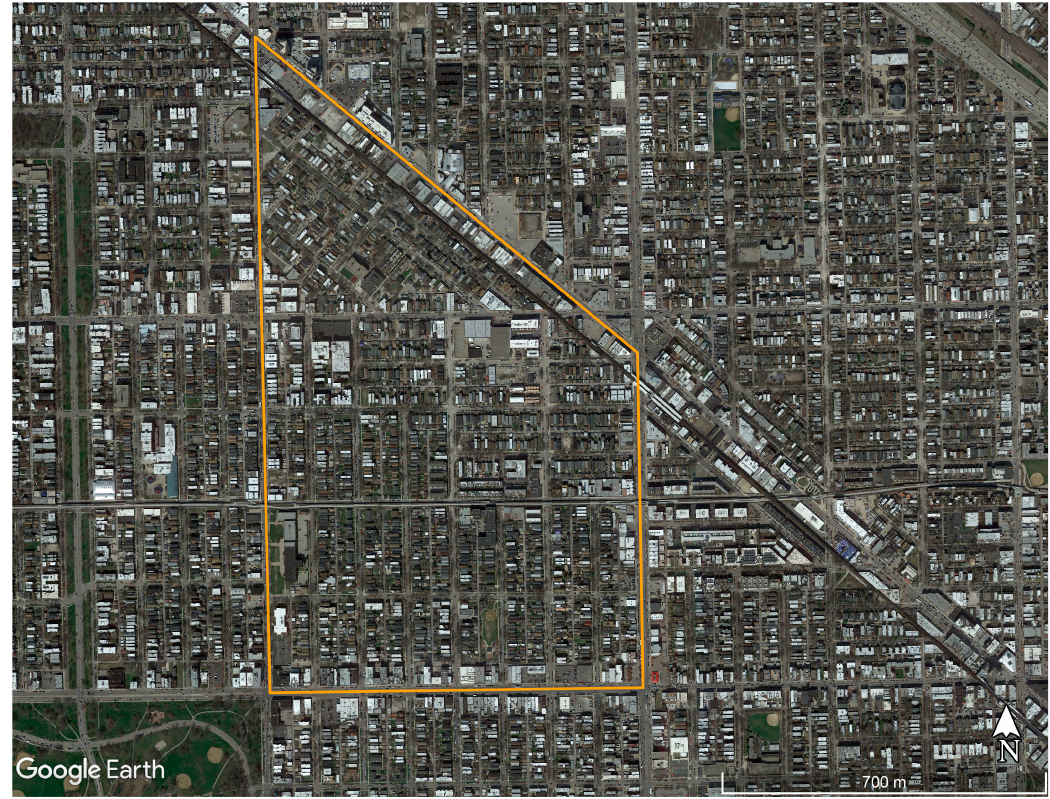
Figure 1. Boundaries of the Cats in My Yard trap-neuter-return (TNR) program area located in the Humboldt Park section of Chicago, IL, USA.